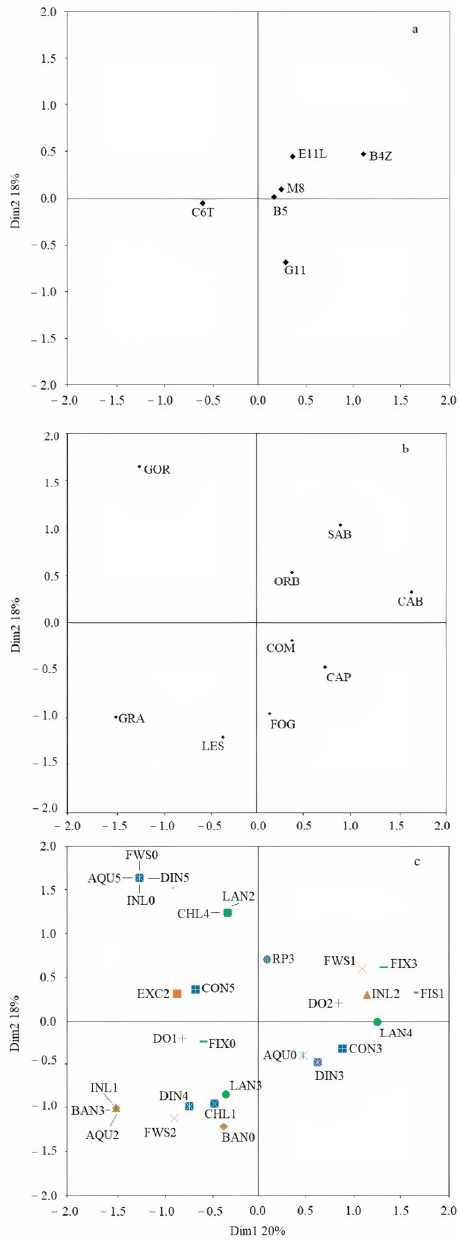
Figure 6. Multiple Correspondence Analysis (MCA): plots of the categorical variables considered. Active variables: skeletal anomalies ( a ) and anthropogenic pressures ( c ); supplementary variable: sites ( b ) (the supplementary variable is shown as the central plot to facilitate the interpretation of the results). ( a ) Skeletal anomalies: malformed zygapophysis of abdominal vertebrae (B4z), malformed neural arches or spine of abdominal vertebrae (B5), Tulip-like shaped hemal arches of the hemal vertebrae (C6T), malformed left pectoral fin rays (E11L), malformed caudal fin rays (G11), and malformed interdorsal element (M8). ( b ) Sites: (ORB) Orbetello, (CAB) Cabras, (FOG) Fogliano, (CAP) Caprolace, (SAB) Sabaudia, (LES) Lesina, (COM) Comacchio, (GOR) Sacca di Goro, (GRA) Grado Marano. ( c ) Anthropogenic pressures: (EXC) Exchange, (BAN) Banks, (INL) Inlet, (FWS) Freshwater supply, (AQU) Aquaculture, (FIS) Fishery, (FIX) Fixed barriers, (LAN) Landscape, (DO) Dissolved Oxygen, (CHL) Chlorophyll- a , (DIN) Dissolved Inorganic Nitrogen, (RP) Reactive Phosphorus, (CON) Contaminants. The numbers in the labels represent the relative score (from 0 to 5) of the specific anthropogenic pressure indicator. Only the variables with cumulative explained inertia > 1% are